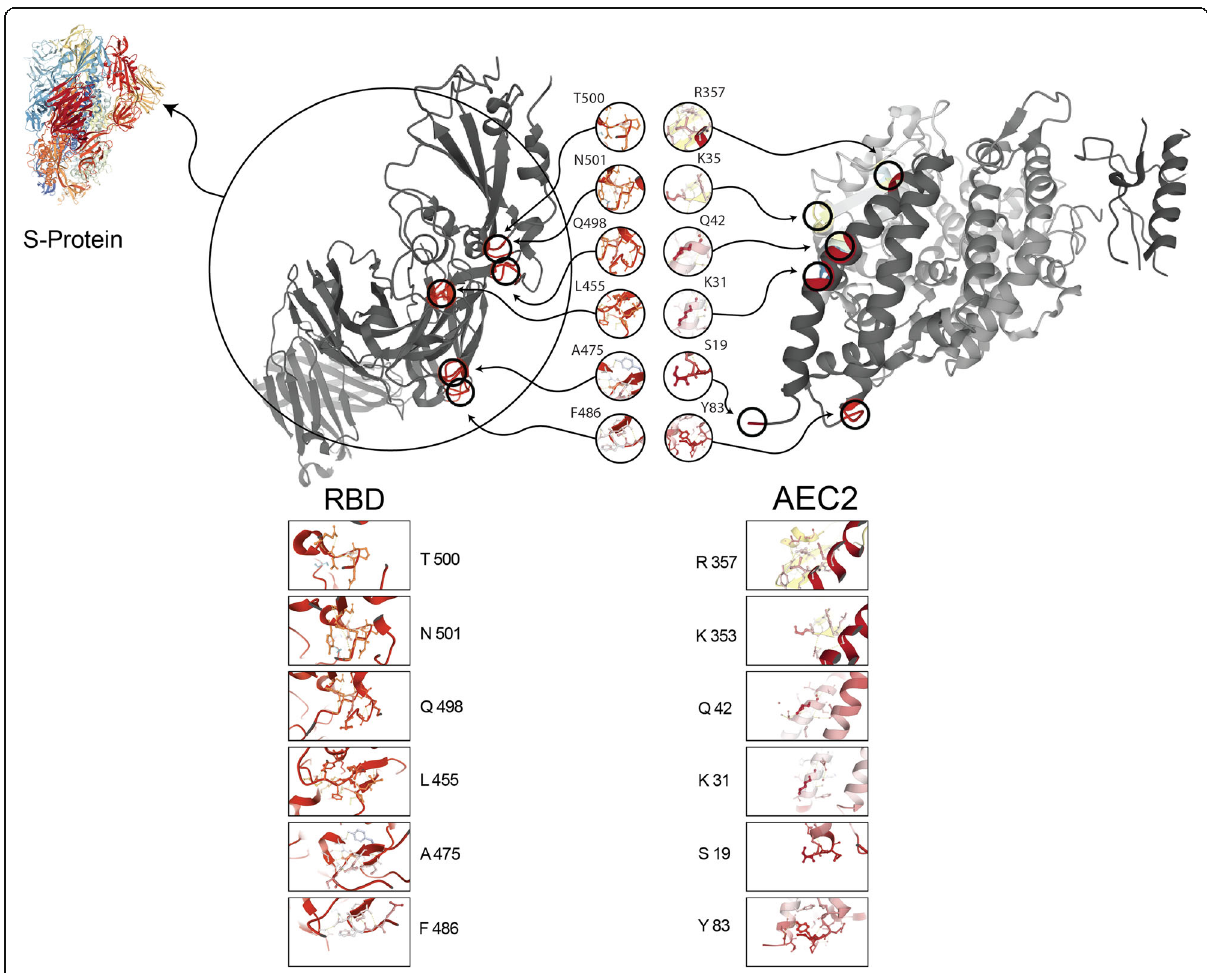
Fig. 1 Cartoon representation of the interaction between SARS-CoV-2S-protein RBD and ACE2. Positions and names of the hot spot residues of the SARS-CoV-2 S-protein RBD/ACE2 are shown. The hydrogen bonds between intra-protein residues are shown by yellow dotted line. The Protein Data Bank (PDB) code for SARS-CoV-2 S-protein is 6VXX, PDB code for RBD region is 7C01 and PDB code for ACE2 is